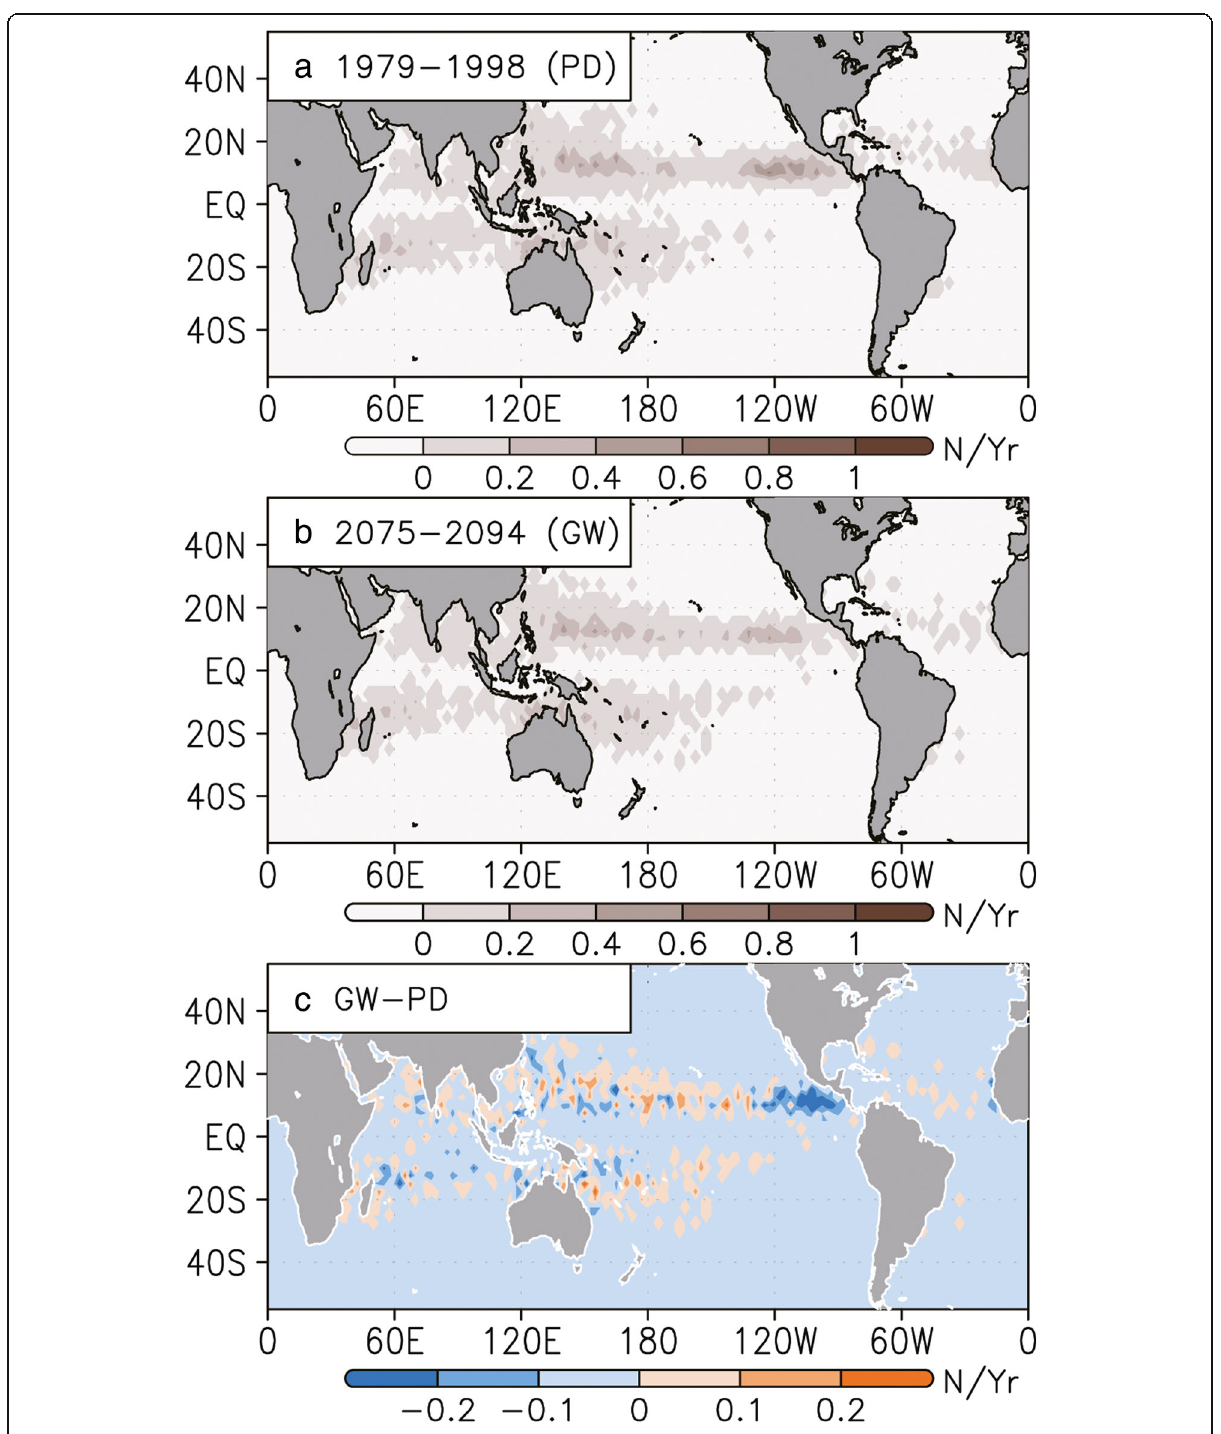
Fig. 12 Geographical distributions of annual TC genesis density. a for the PD simulation for 1979 – 1998; b for the GW simulation of 2074 – 2093; c shows the difference between the GW and PD simulations. TC genesis density is defined as the number of TCs generated in each 2.5°×2.5° grid box per